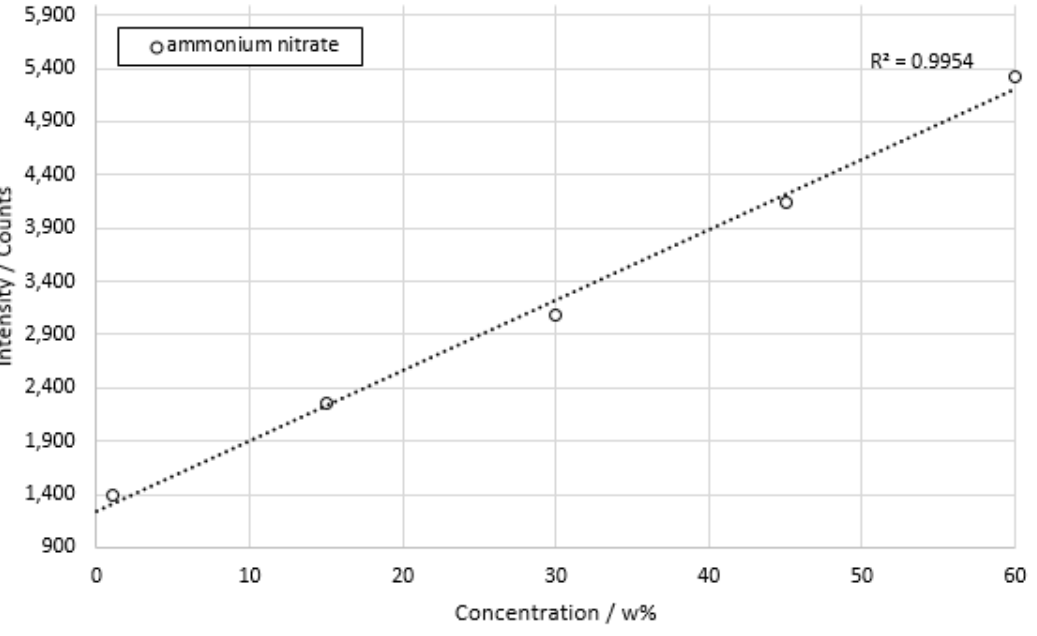
Figure 10. Concentration series of ammonium nitrate dissolved in deionized water. Integration time 100 ms; total measuring time 2 min per concentration.